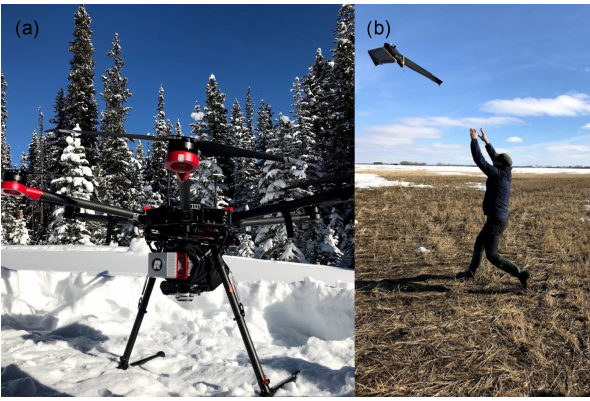
Figure 2. UAV-lidar platform: RIEGL miniVUX-1UAV mounted on DJI M600 Pro (a) . UAV-SfM platform: senseFly eBee X (b)